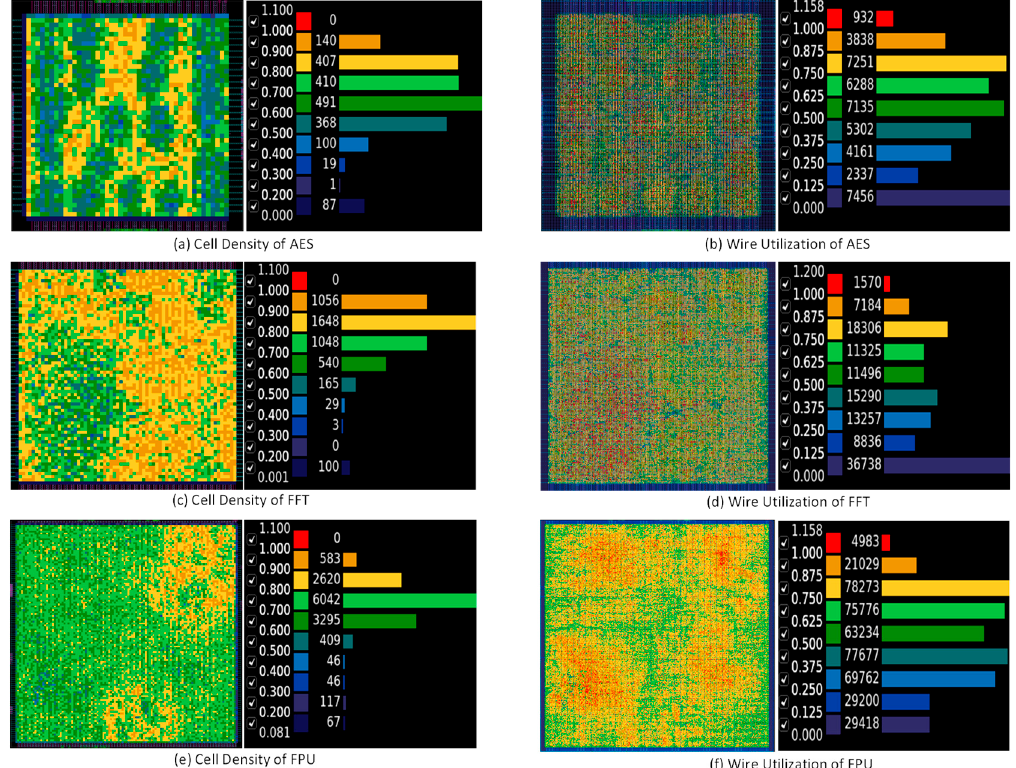
Figure 12. Cell density and wire utilization plots for the different benchmark circuits.